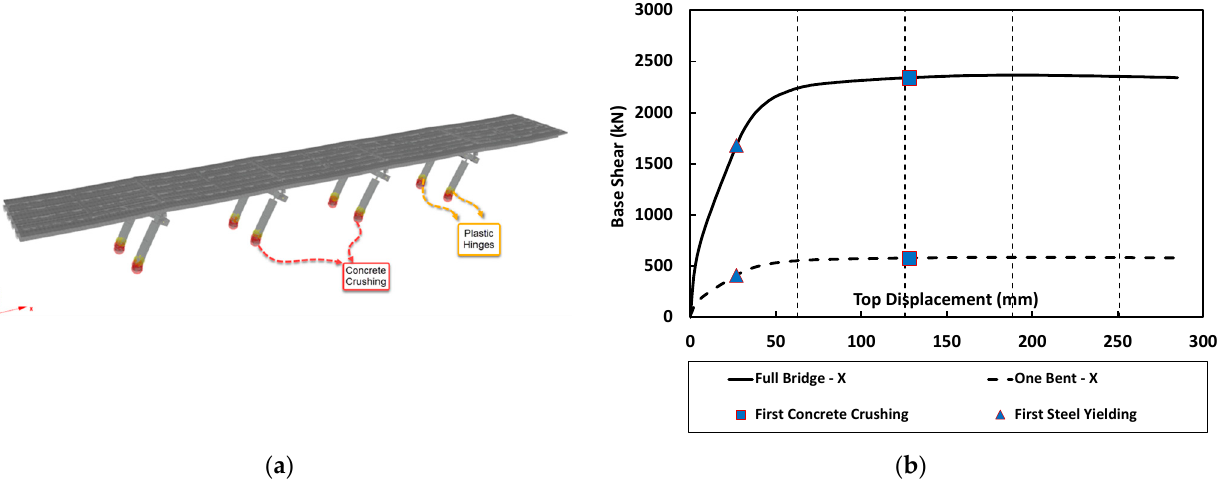
Figure 12. Pushover analysis results in the longitudinal (X) direction: ( a ) deformed shape and damage locations, and ( b ) capacity curves of the one bent and the whole bridge.